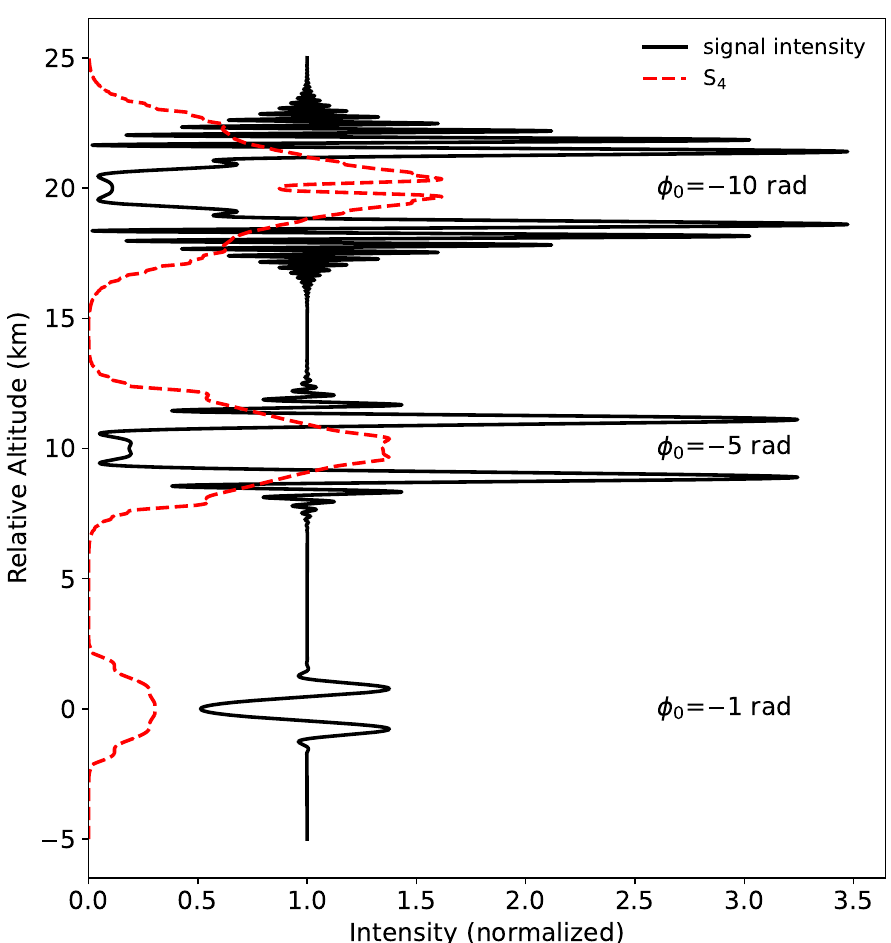
Figure 4. Simulated signal intensity and S 4 at the LEO measurement plane for the Gaussian lenses displayed in Figure 3. Note the elevated S 4 near the center caused by the reduced mean at the bottom of the U-shaped profile. The lenses were shifted by 10 km in altitude for readability, and a window of 2.2 km was used for S 4